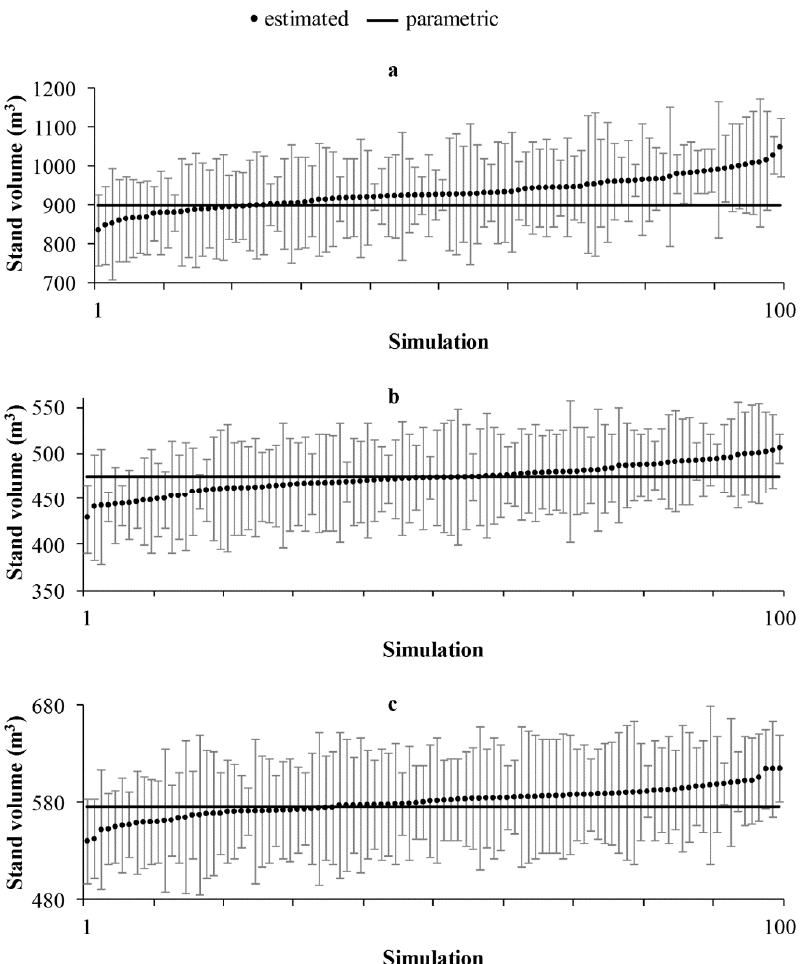
Figure 2. Confidence interval and stand volume based on simulations in the area approach (conventional forest inventory). ( a ) Pinus taeda —16 years old (stand 1); ( b ) Pinus taeda —7 years old (stand 2); ( c ) Eucalyptus urograndis —5 years old (stand 3).